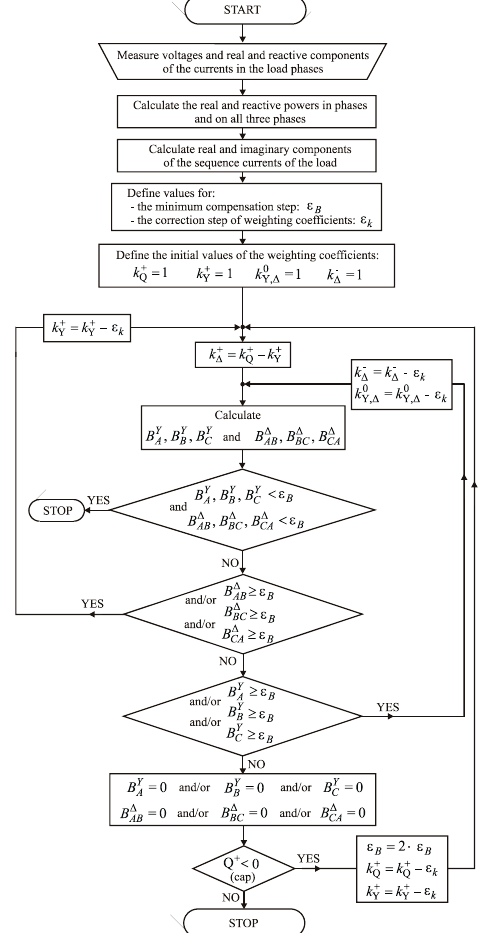
Figure 3. Simplified flowchart associated with the iterative method.